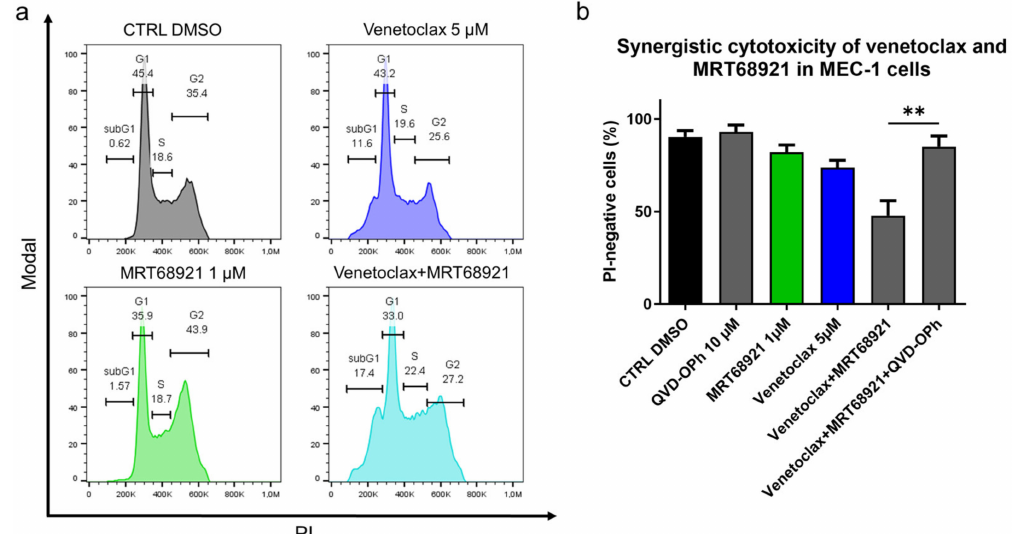
Figure 8. Mechanistic insight into the synergistic cytotoxicity of venetoclax and MRT68921 in CLL cells. ( a ) Cell cycle analysis of MEC-1 cells (3 × 10 5 cells/mL) treated with 5 µ M venetoclax, 1 µ M MRT68921, and their combination for 24 h. A representative experiment is shown; ( b ) Caspases are essential for synergistic cytotoxicity of venetoclax and MRT68921. MEC-1 cel cellsls (3 × 10 5 /mL) were treated with a combination of 5 µ M venetoclax and 1 µ M MRT68921, 10 µ M QVD-OPh, and their combination for 24 h. The cell viabilities were determined by 5 µ M propidium iodide staining and analysis by flow cytometry. Data are means ± SEM of 3 independent experiments. Student’s t -test was used. ∗∗ denotes p <